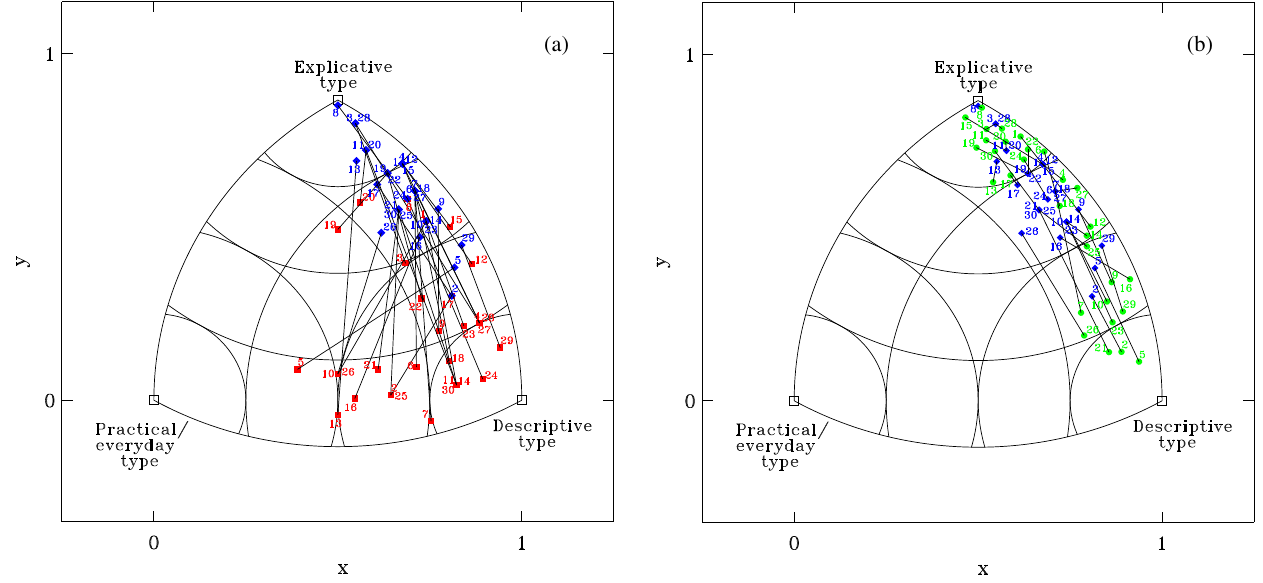
FIG. 3. Similarity graph for pre or post (a) and post or post-4y (b) instruction data. The squares at the vertexes of an equilateral triangle represent the practical or everyday, descriptive and explicative typologies. The x and y represent the coordinates in the similarity space. The concentric circumferences mark the distances 0.25, 0.5, 0.75, and 1 from the vertexes, the colored or numbered symbols represent the